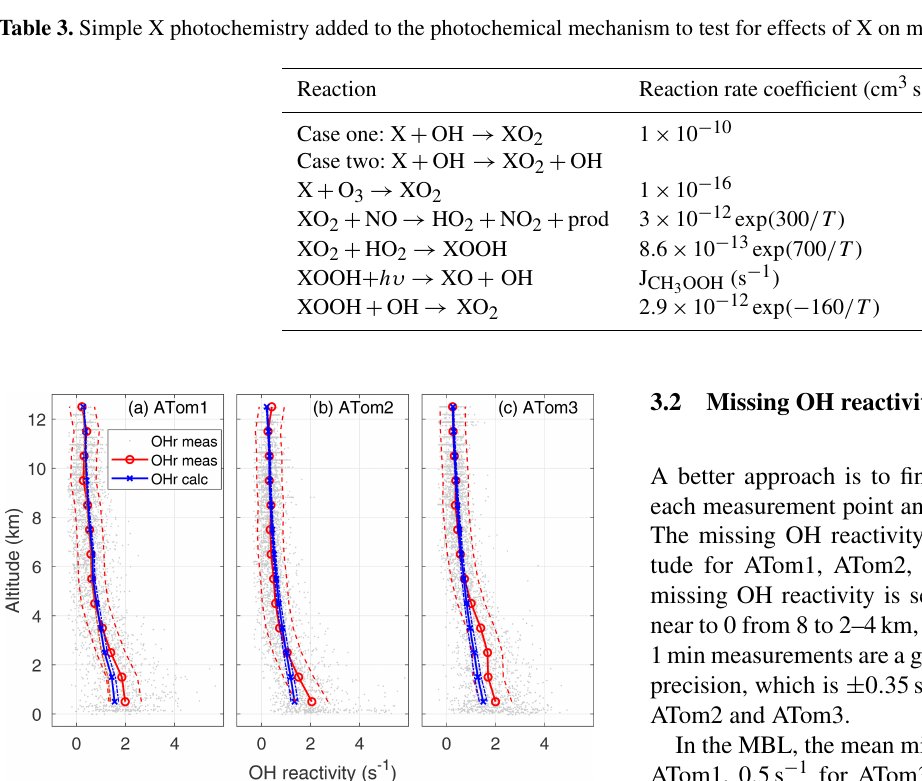
Figure 4. OH reactivity versus altitude for ATom1 (August), ATom2 (February), and ATom3 (October). One-minute measured OH reac- tivity (gray dots), median measured OH reactivity (OHr meas) in 1km altitude bins (red circle and line), median calculated OH reac- tivity (OHr calc) in 1km altitude bins (blue x’s and line), and ab- solute OHR uncertainty (95% confidence level) for measured and calculated OH reactivity (dashed lines) are shown as a function of